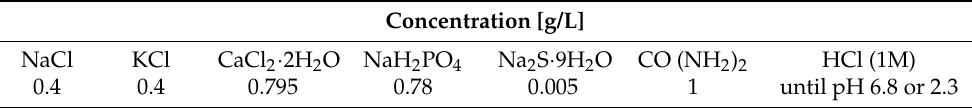
Table 2. Chemical composition of the Fusayama-Meyer artificial